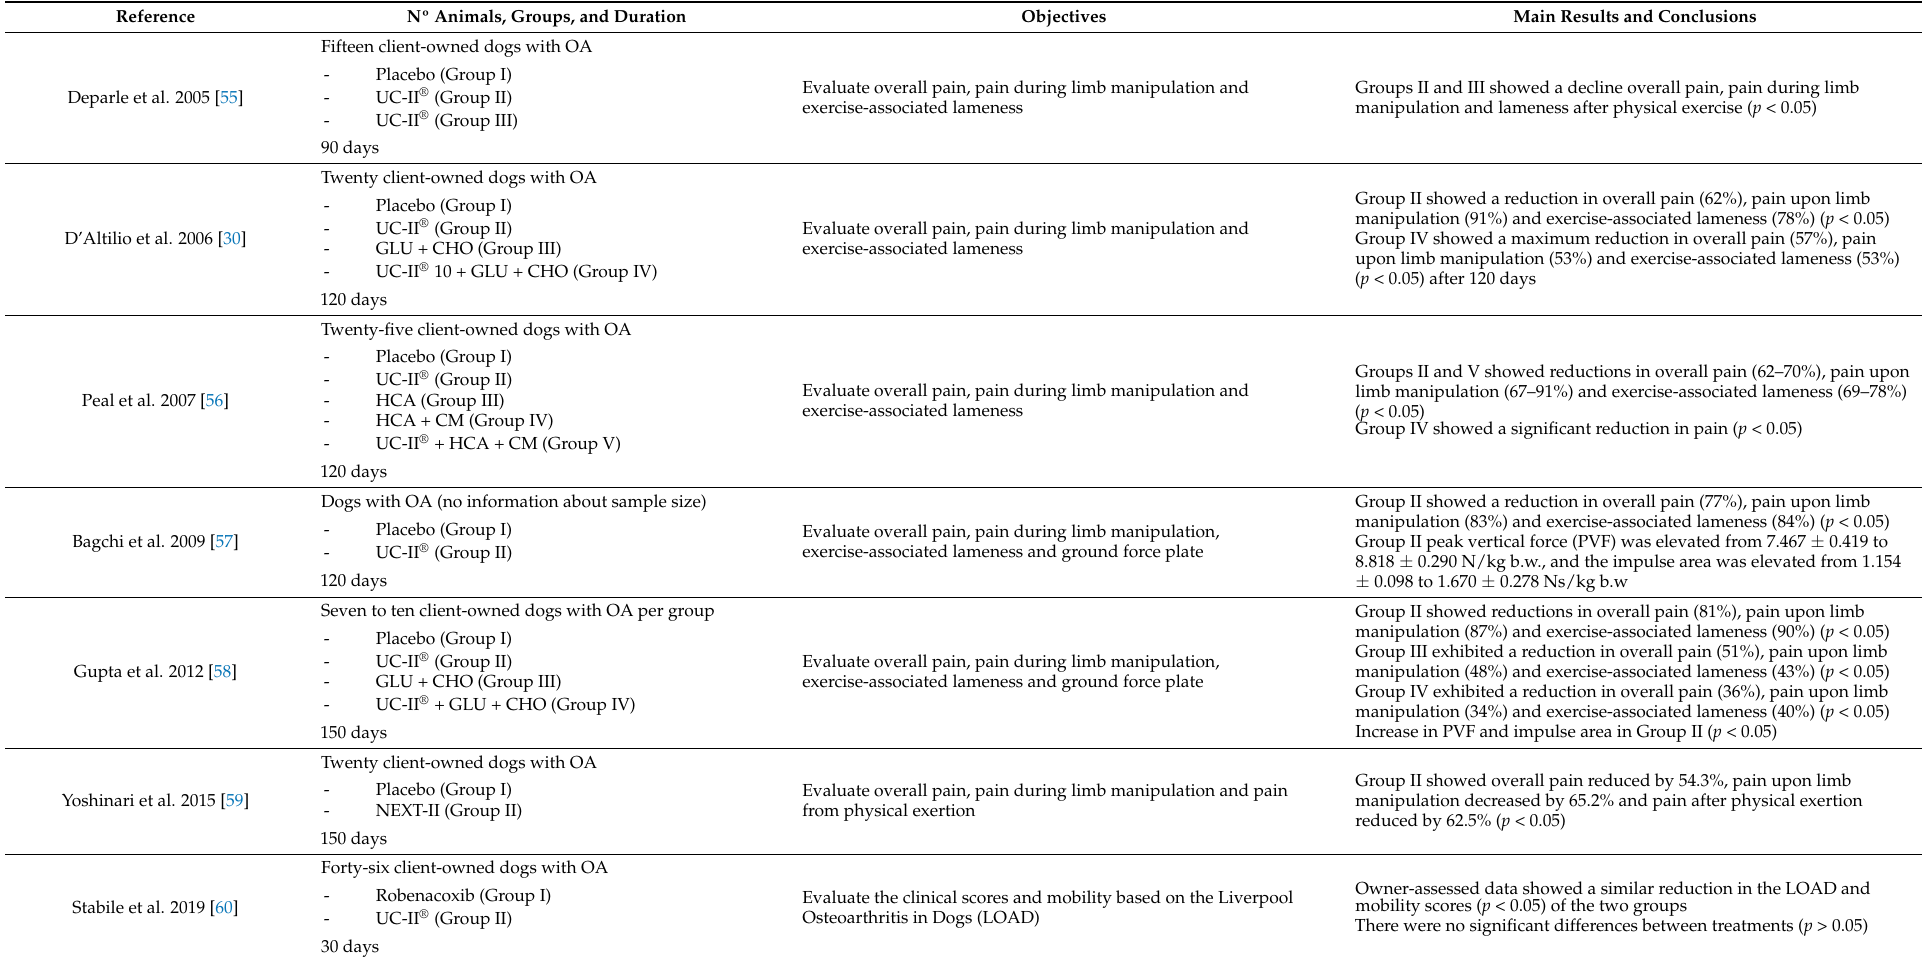
Table 5. Literature overview of evidence regarding undenatured type II collagen for the management of osteoarthritis (OA) and joint support in